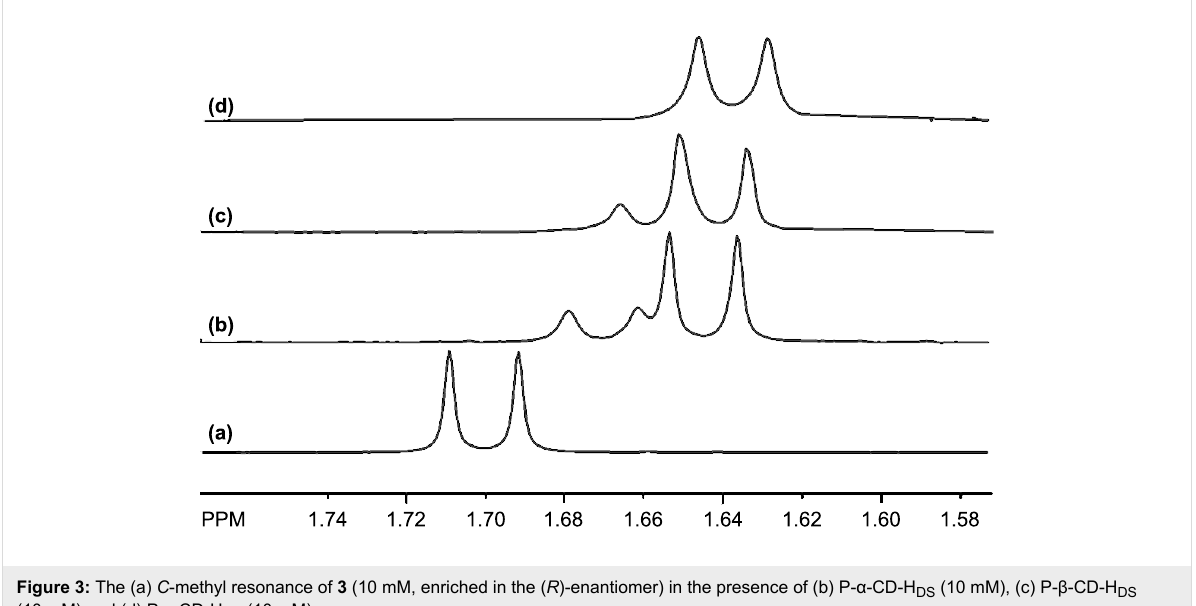
Figure 3: The (a) C -methyl resonance of 3 (10 mM, enriched in the ( R )-enantiomer) in the presence of (b) P- α -CD-H DS (10 mM), (c) P- β -CD-H DS (10 mM) and (d) P- γ -CD-H DS (10 mM).